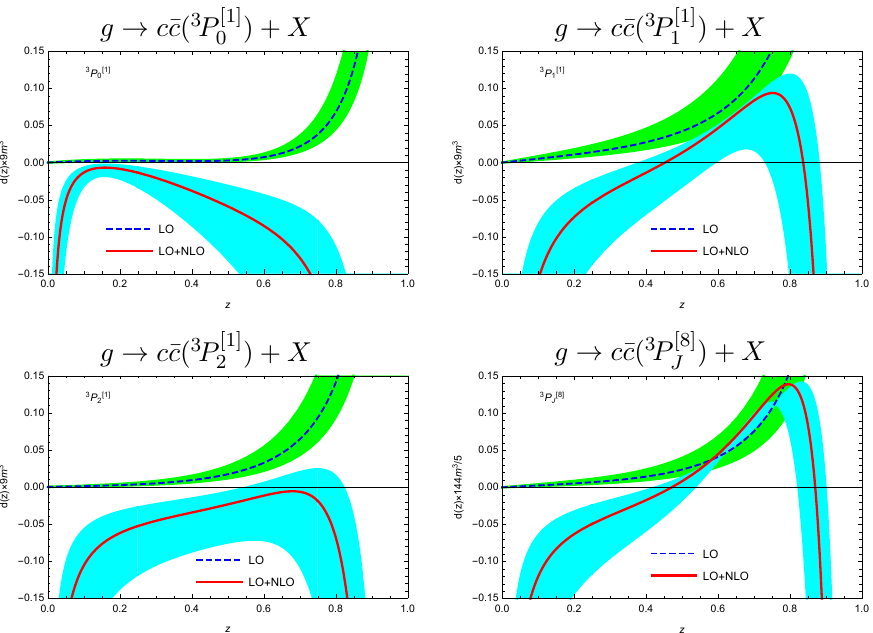
Figure 5 . SDCs of the fragmentation functions of g → c ¯ c ( 3 P [1 , 8] dashed line is for d LO ( z ) × c [1 , 8] , and the solid line is for ( d LO ( z ) + d NLO ( z )) × c [1 , 8] , with scale choices µ r = µ 0 = µ Λ = 2 m c , c [1] = 9 m 5 bands are obtained by varying the renormalization scale µ r by a factor of 2.